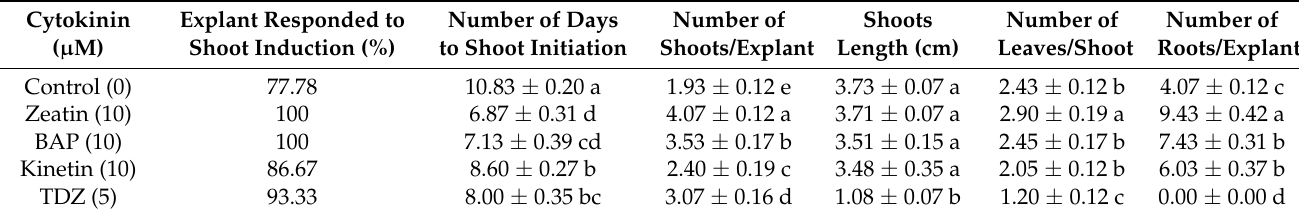
Figure 1. Micropropagation of ‘Bentong’ ginger. ( A ) Rhizome sprouted bud of ‘Bentong’ ginger used as explant for culture initiation; ( B ) aseptically established culture when surface sterilized with 70% Clorox after four weeks of inoculation; ( C ) in vitro-raised shoot used as explant for shoot multiplication (after 10 days of inoculation on MS medium supplemented with 10 µ M zeatin); ( D ) multiple shoots produced in MS medium supplemented with 10 µ M of zeatin after six weeks of inoculation; ( E ) in vitro-raised shoot used as explant for rooting; ( F ) in vitro-rooted plantlet derived from MS medium supplemented with 7.5 µ M NAA after four weeks of culture; ( G ) acclimatized plantlets after three weeks of acclimatization; ( H ) in vitro-raised plant of ‘Bentong’ ginger after seven months of transplanting. Table 2. Effects of different types of cytokinins on the percentage of explants responded to multiple shoots induction, number of days to shoot initiation, number of shoots per explant, shoot length, number of leaves per shoot, and number of roots per explant of ‘Bentong’ ginger after six weeks of